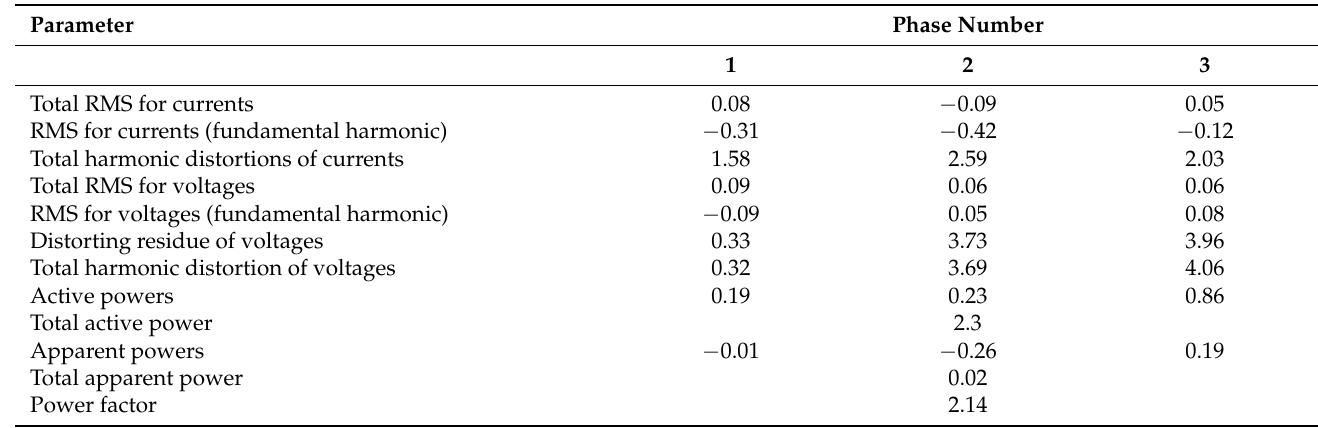
Table 3. Computed percentage relative differences between power quality indices (FFT vs. DWT)— first case